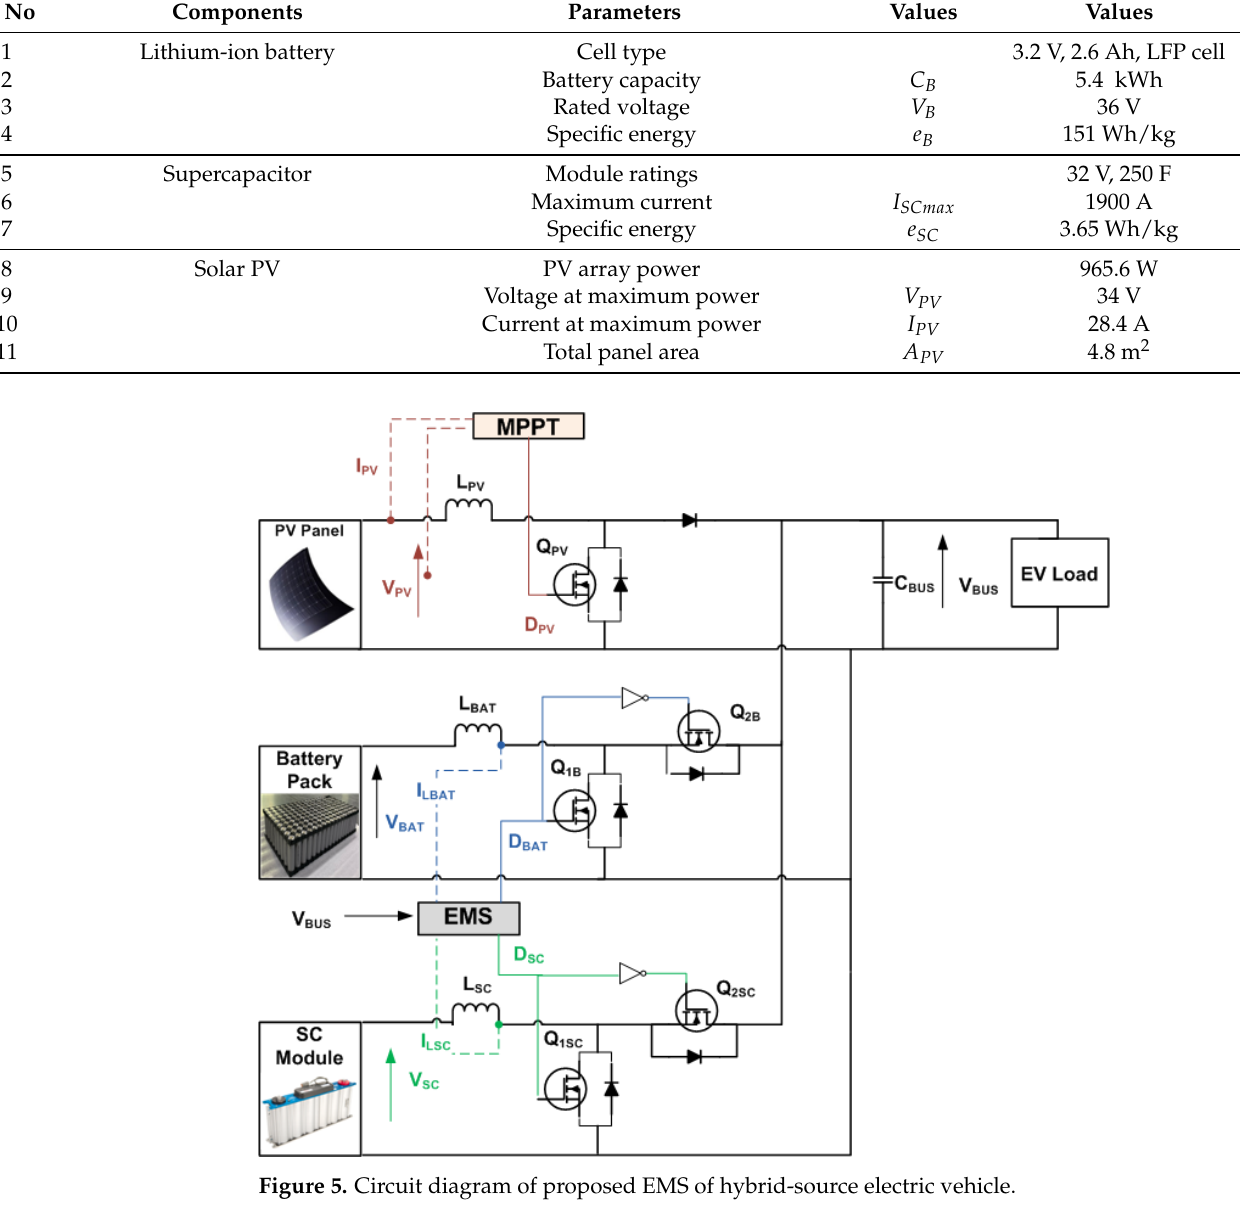
Table 2. Design parameters of hybrid sources.